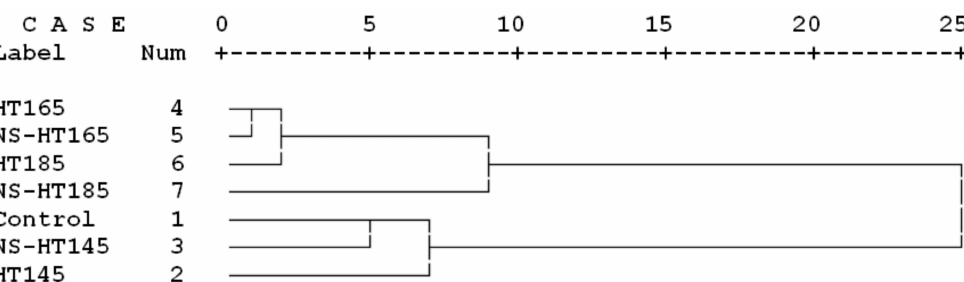
Figure 8. Contour and surface plots among MOR, MOE (mechanical properties), and impact bending in the seven treatments studied in the present project.